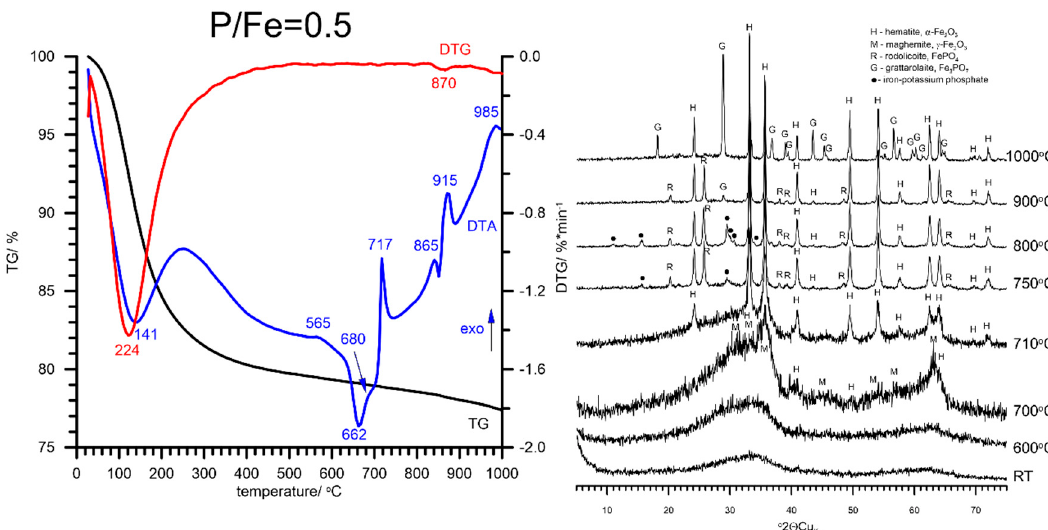
Figure 6. The results of thermal analysis and XRD patterns of P-doped synthetic ferrihydrite at the P/Fe molar ratio of 0.5. The formation of rodolicoite as an unstable intermediate at 717 °C is followed by transformation into grattarolaite Fe 3 PO 7 , which remains stable along with α -hematite up to 1000 °C. Note the formation of nanomaghemite γ -Fe 2 O 3 at around 700 °C.